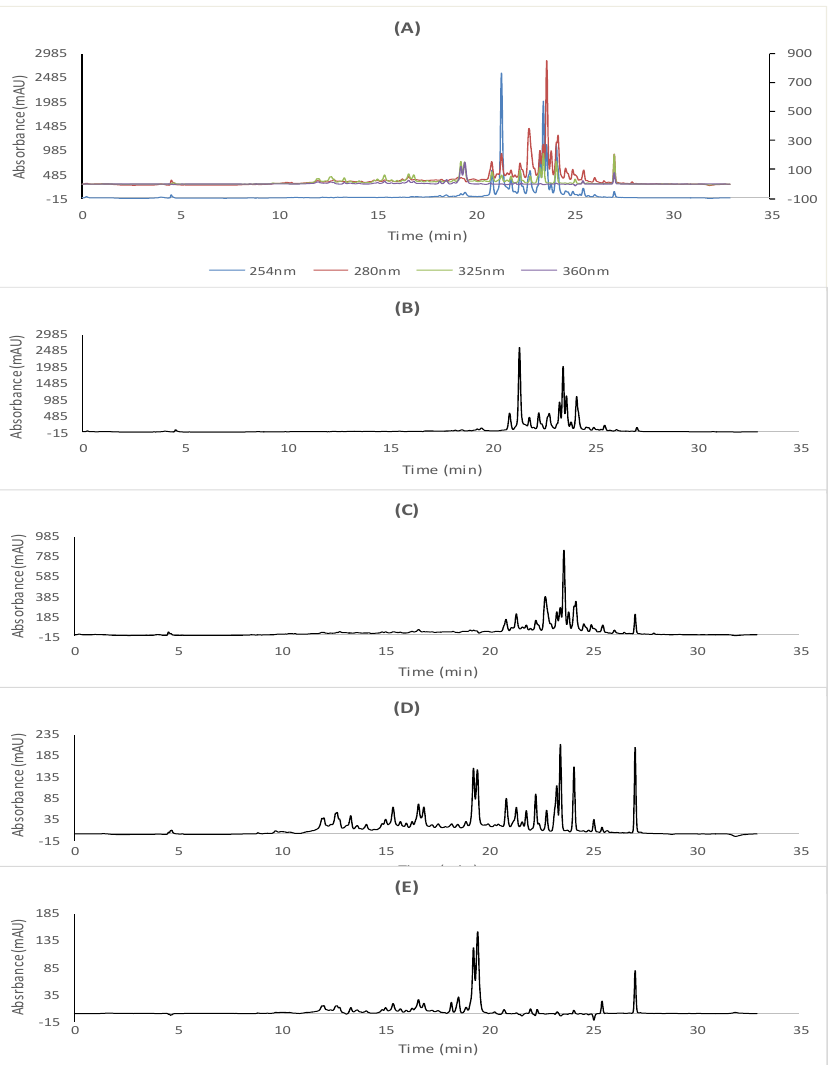
Figure 2. LC − DAD chromatogram of secondary metabolites from R. tuberculata methanolic extract. ( A ) Global chromatograms detected at four wavelengths ( B ) at 254 nm, ( C ), at 280 nm ( D ), at 325 nm and ( E ) at 360 nm.